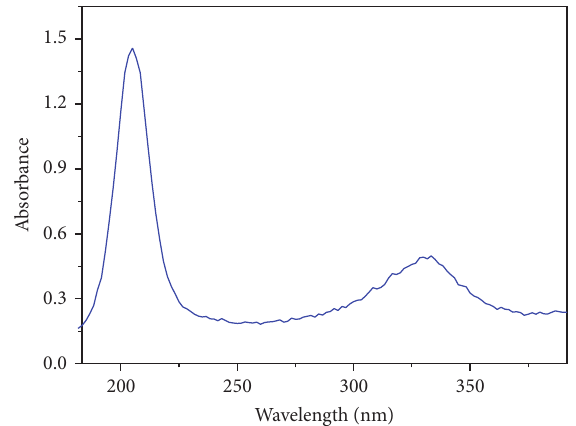
Figure 1: UV-visible spectra of CuO NPs synthesized using aqueous extract of S. indica